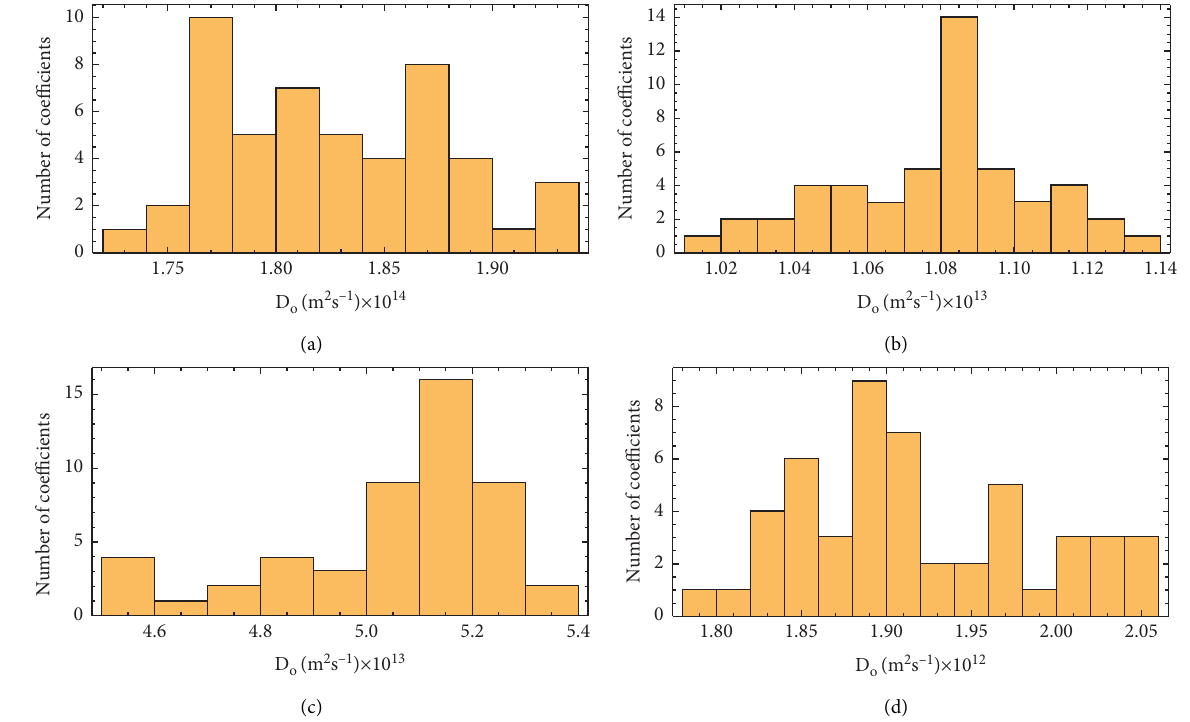
Figure 7: Distributions of diffusion coefficients in the case of the 3.22mol% Re supercell. The coefficients were obtained from our ABC method focusing on the last 50 KMC steps. The temperature was set to (a) 1200K, (b) 1300K, (c) 1400K, and (d) 1500K.